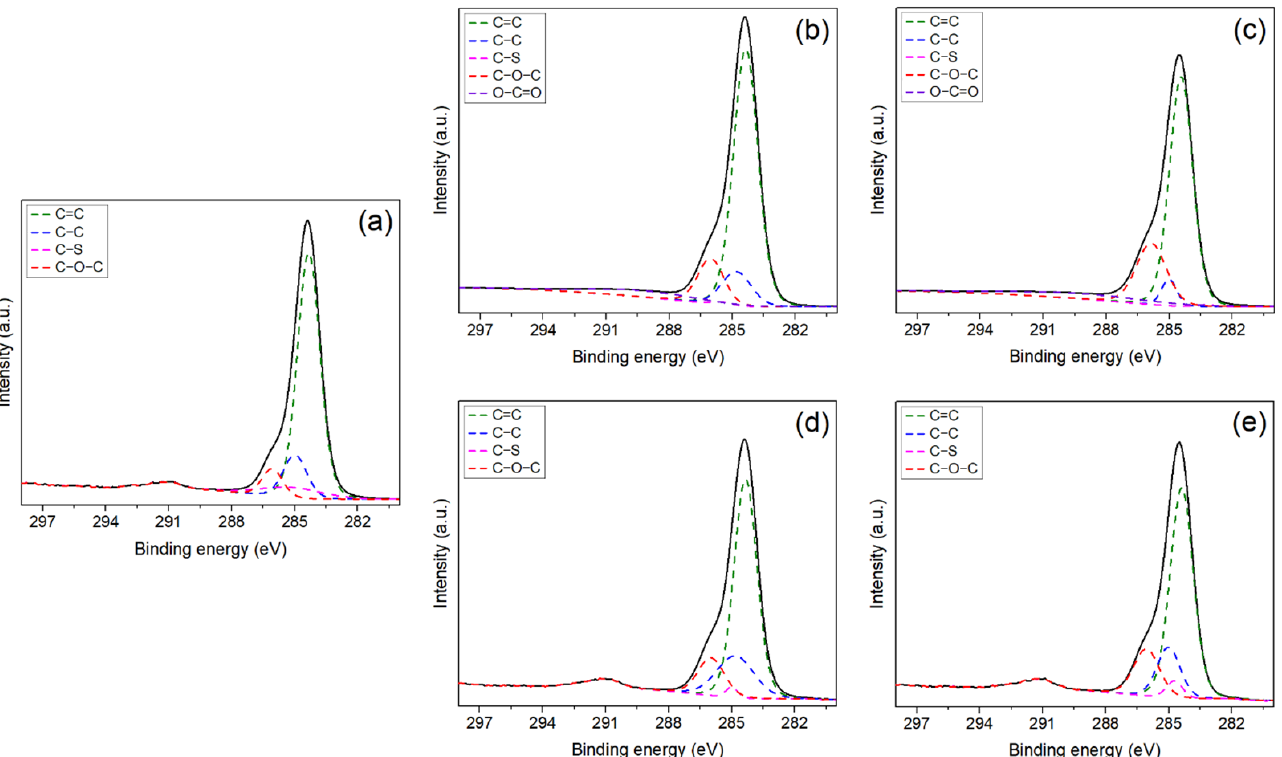
Figure 7. High-resolution C1s XPS spectra of fabricated membranes: ( a ) P, ( b ) GP-1, ( c ) GP-2, ( d ) ZP-1, and ( e ) ZP-2.